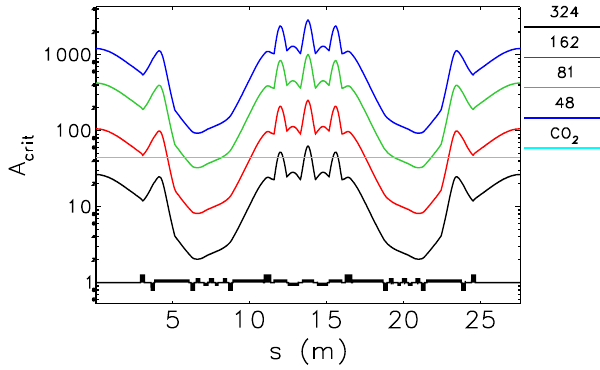
FIG. 10. Critical mass for 25 mA total beam current. Each line represents the critical mass for a different number of equally spaced bunches.